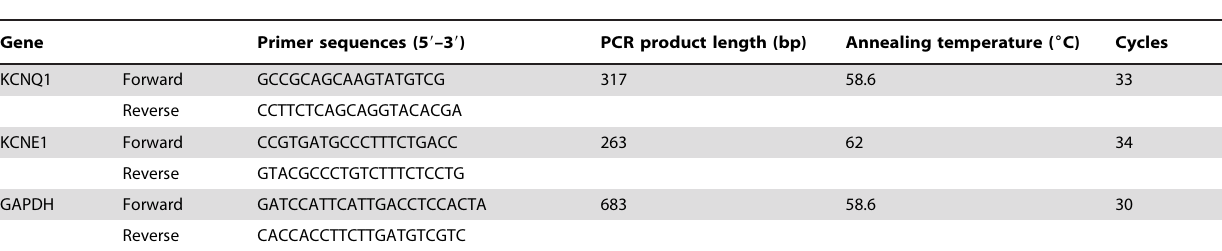
Table 6. Details of